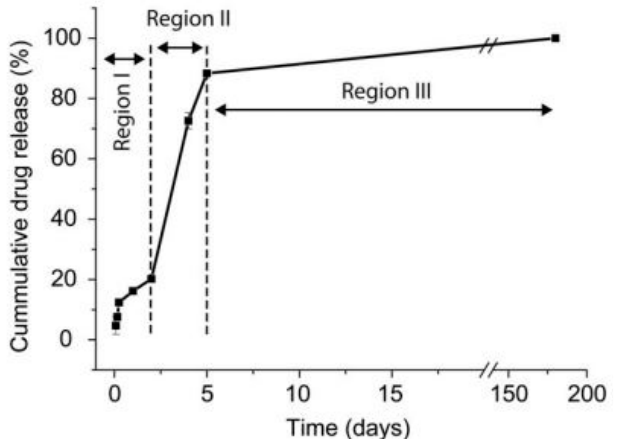
Figure 6. Cumulative release of lawsone from EPD coating of chi/BG/Lawsone on SS. Reproduced from [74].